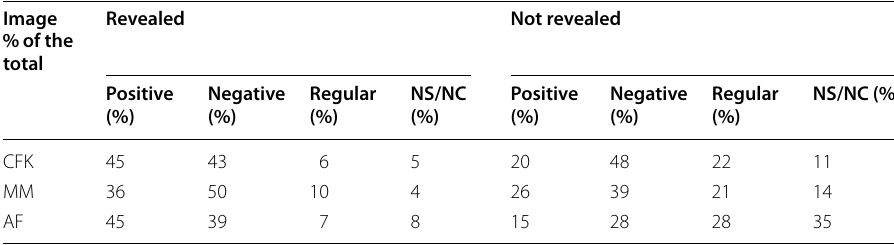
Table 3 CFK, AF and MM candidate Image in the Elypsis surveys as % of the total according to those respondents who revealed their intention of vote to the pollster and those who did not Image % of the total